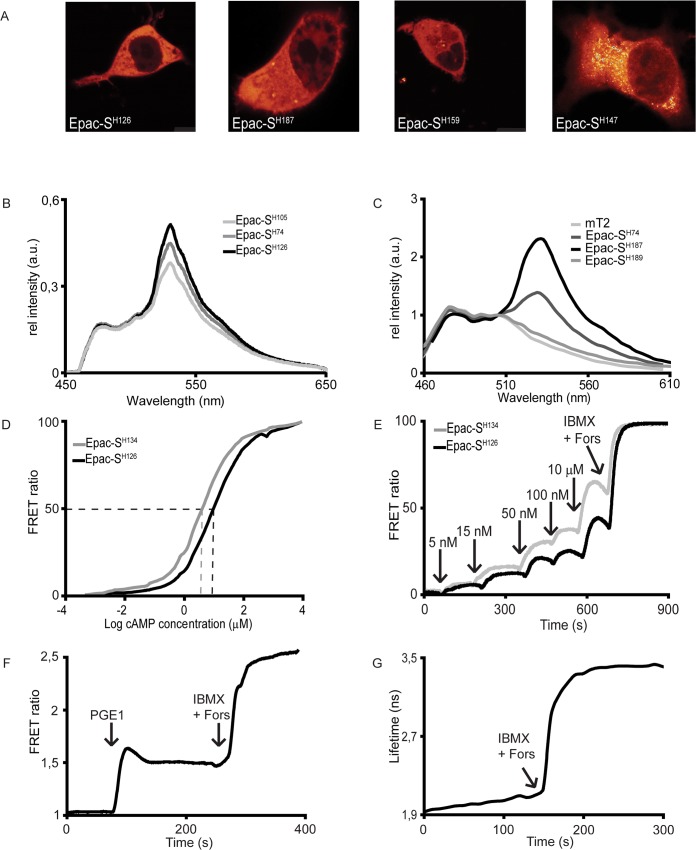
Characterization of novel FRET sensors.A. Localization of the FRET-sensors: N1E-115 cells transfected with mTurquoise2Δ-Epac(CD, ΔDEP)-cp173Venus-Venus (Epac-SH126); mTurquoise2Δ-Epac(CD, ΔDEP, Q270E)-tdcp173Venus (Epac-SH187); mTurquoise2Δ-Epac(CD, ΔDEP)-tdcp173Dark Venus (Epac-SH159) and mTurquoise2Δ-Epac(CD, ΔDEP)-cp174Cit (Epac-SH147). Images were taken 18 hours after transfection. B. FRET efficiency of constructs with different donors. Emission spectra of U2OS cells expressing constructs with donors Cerulaen3 (Epac-SH105); mTurquoise (Epac-SH74) or mTurquoise2 (Epac-SH126) were acquired while exciting at 436 nm. Spectra are normalized to CFP intensity after correction for expression levels (using Venus brightness, excited at 500 nm as detailed in M&M). C. Spectra of constructs with various acceptors. Shown are spectra from N1E-115 cells expressing Epac with acceptor cp173Venus-Venus (Epac-SH134); tdcp173Venus (Epac-SH187) or tdcp173Dark Venus (Epac-SH189), illuminated with a 442 nm laser. Emission spectra were normalized to isosbestic point at 505 nm. D. Calibration curves for normal and high-affinity sensors. Shown are the average of three independent calibrations performed on cell lysates of HEK293T cells expressing the indicated constructs. cAMP was titrated in under continuous stirring. The sensors were excited at 420 +/- 3 nm and emission was measured at 530 +/- 10 nm and 490 +/- 10 nm for YFP and CFP respectively. Ratios were calculated as YFP over CFP and were normalized between baseline 0% and maximum response 100%. E. In-vivo experiment revealing the difference between high- and normal affinity sensors (Epac-SH126 or Epac-SH134) expressed in Hek293T cells. Isoproterenol induces a graded increase in cAMP levels in these cells and was added in increasing amounts as indicated. Signals were normalized between baseline 0% and maximum response 100%. Representative experiment out of 3 repeats. F. Typical FRET time-lapse trace in N1E-115 cells expressing Epac-SH187. After recording a baseline, at t = 90 s PGE1 (5 μM) was added, and at t = 250 s IBMX (100 μM) and Forskolin (25 μM) were added for calibration. G. A FLIM-FRET time-lapse recording from N1E-115 cells expressing Epac-SH189. A baseline was followed by addition of IBMX (100 μM) and Forskolin (25 μM) after 140 seconds.